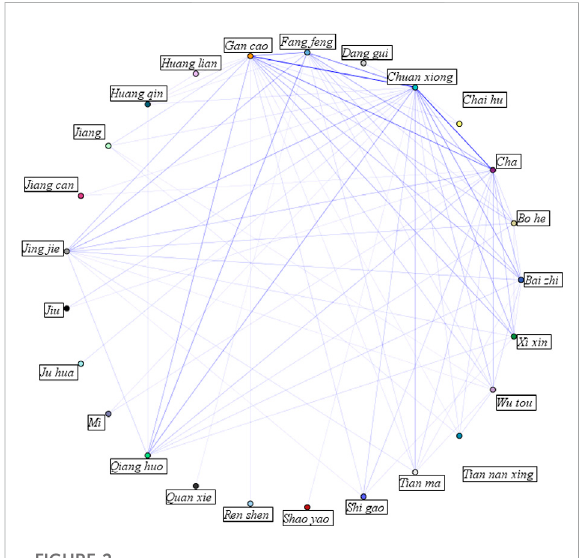
FIGURE 2 Network diagram of association rules between